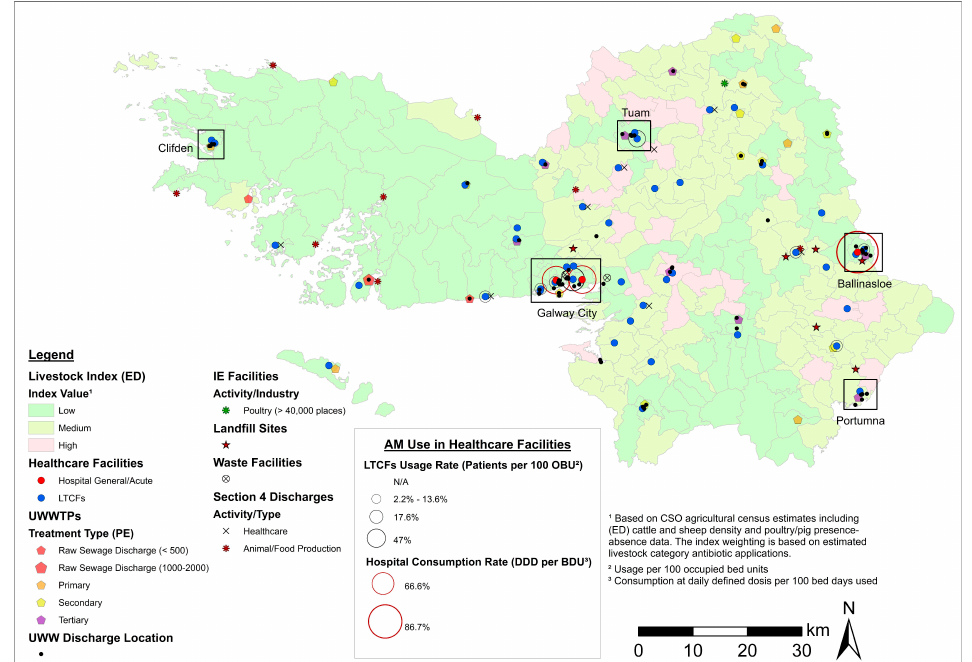
Figure 3. Map of potential ARO sources (classified) and healthcare facilities (including AM use) in County Galway (including Galway City). Notes: Livestock index estimates are included as a base map layer. Clusters of AROs sources in urban areas are delineated. ED = electoral district. UWWTPs = urban wastewater treatment plants. UWW = urban wastewater. IE = industrial emissions. PE = population equivalent (i.e., estimated population served by